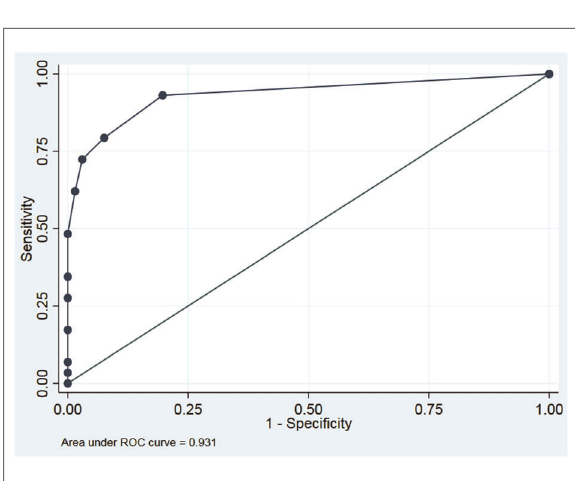
FIGURE 2 Area under the receiver operating characteristic (ROC) curve at cutoff value